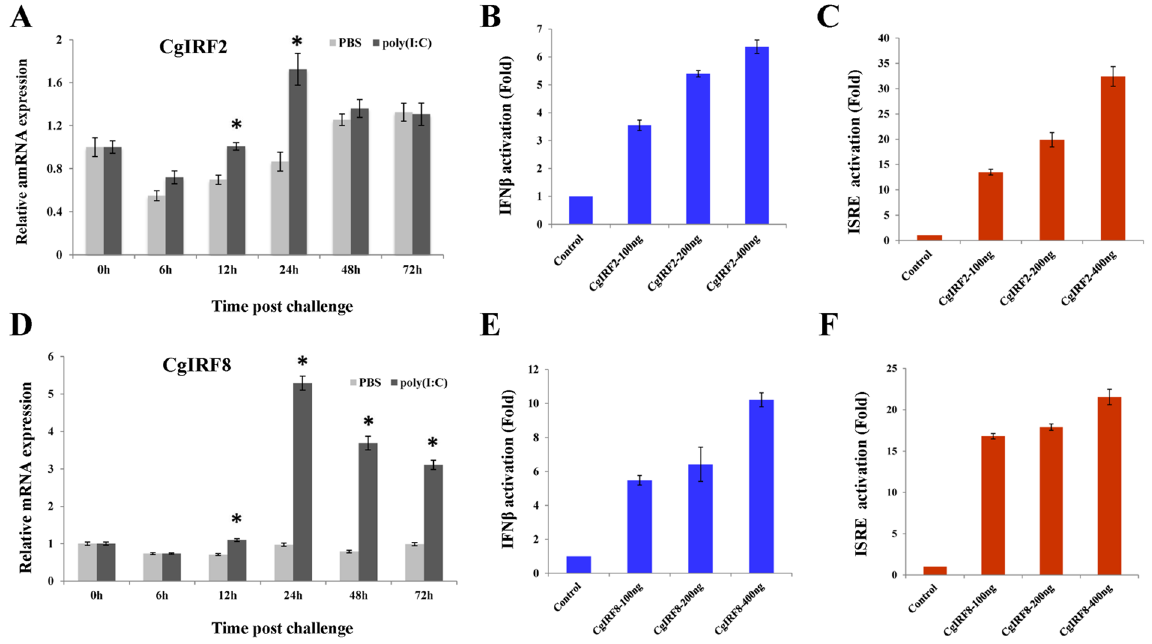
Figure 7. CgIRF2 and CgIRF8 respond to poly(I:C) challenge and activate human IFN β and ISRE promoters. ( A ) Expression profile of CgIRF2 mRNA after poly(I:C) challenge analysed by qRT-PCR. ( B and C ) CgIRF2 specifically activated the human IFN β ( B ) and ISRE ( C ) promoters in a concentration-dependent manner. The activation was detected using dual luciferase reporter assays in human HEK293T cells. ( D ) Expression profile of CgIRF8 mRNA after poly(I:C) challenge analysed by qRT-PCR. ( E and F ) CgIRF8 specifically activated the human IFN β ( E ) and ISRE ( F ) promoters in a concentration-dependent